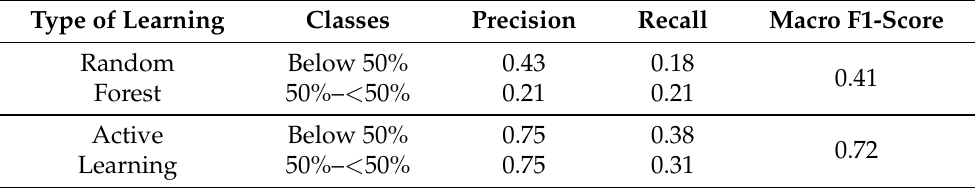
Figure 7. Results for Model 2 with AL after 50 queries performed with confusion matrix ( a ) and MLP algorithm ( b ). Table 5. Comparison between RF and AL for predicting sparse labels for Model